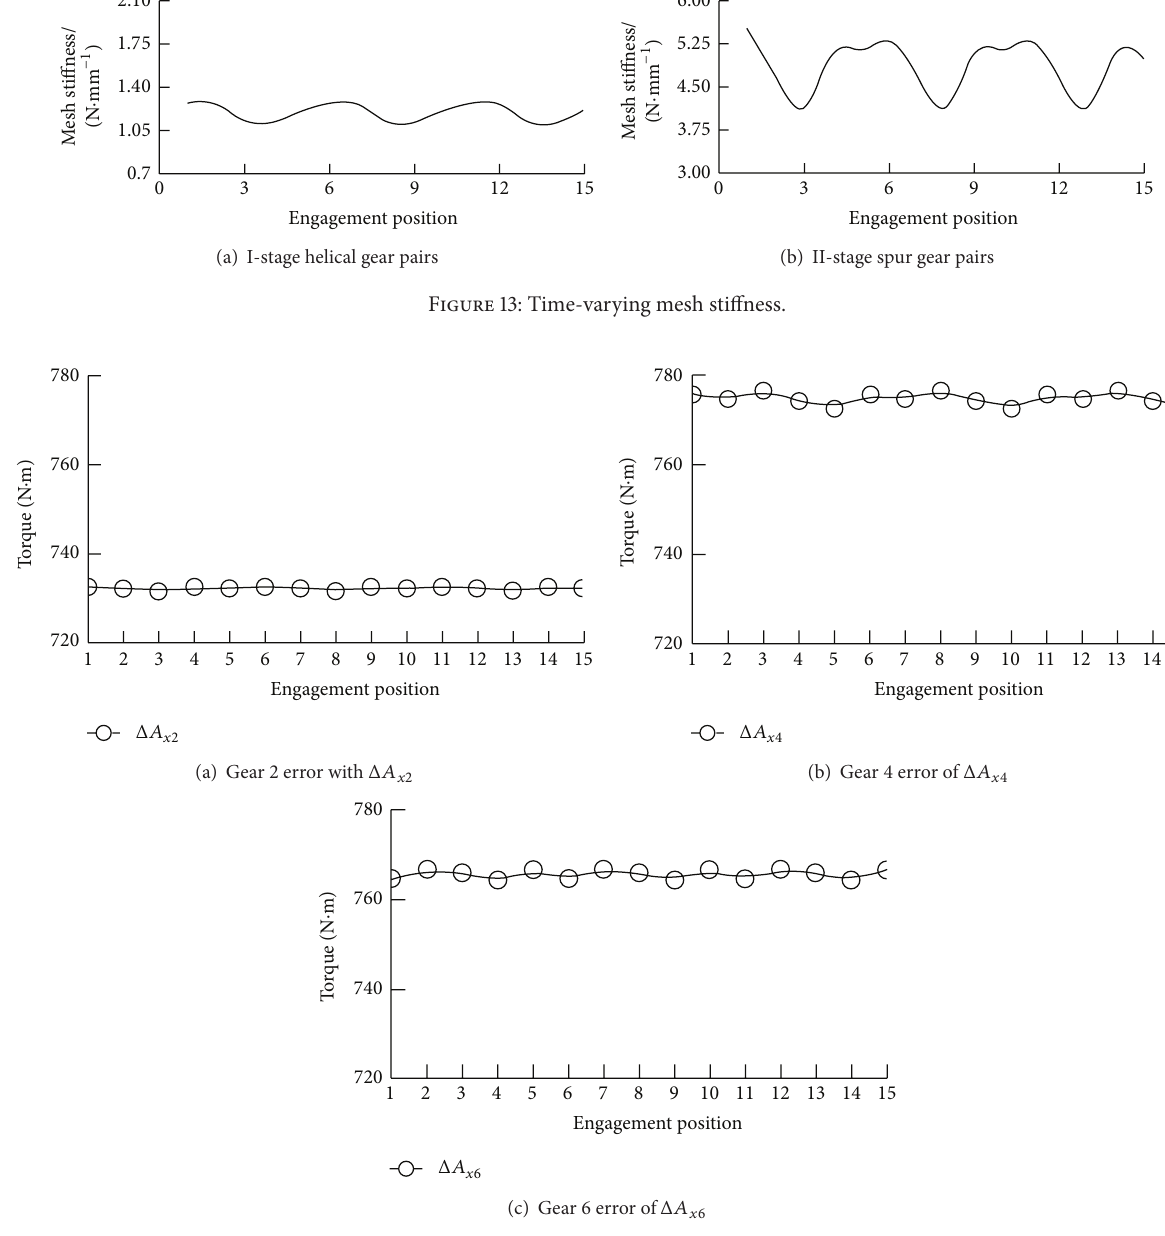
Figure 14: Load-sharing coefficient with installation